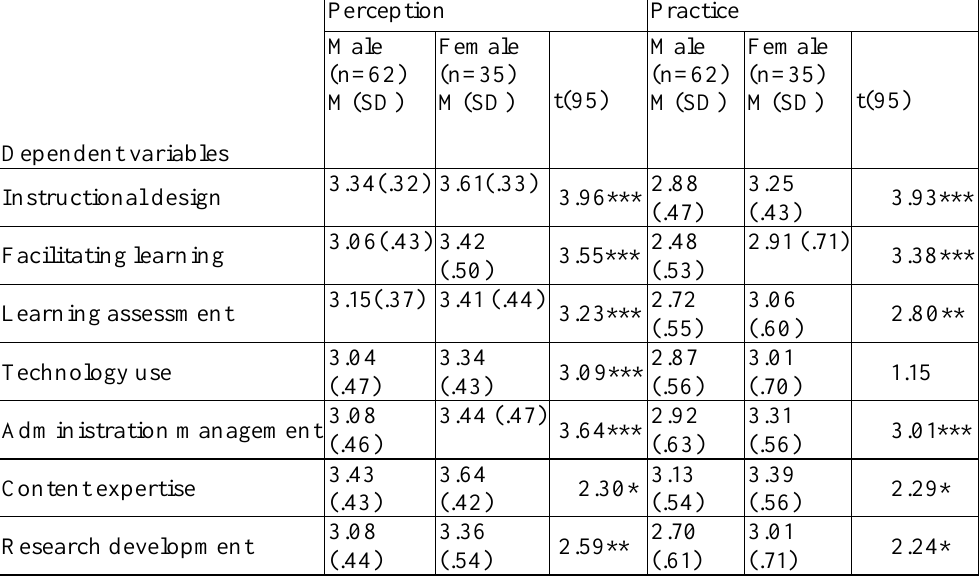
Table 2 Perception and Practice between Male and Female E-Instructors toward Online